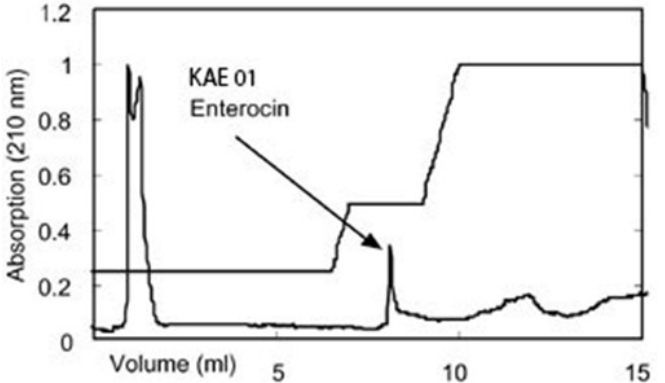
Figure 4. Purification to homogeneity of enterocin protein using fast-performance liquid chromatog- raphy of